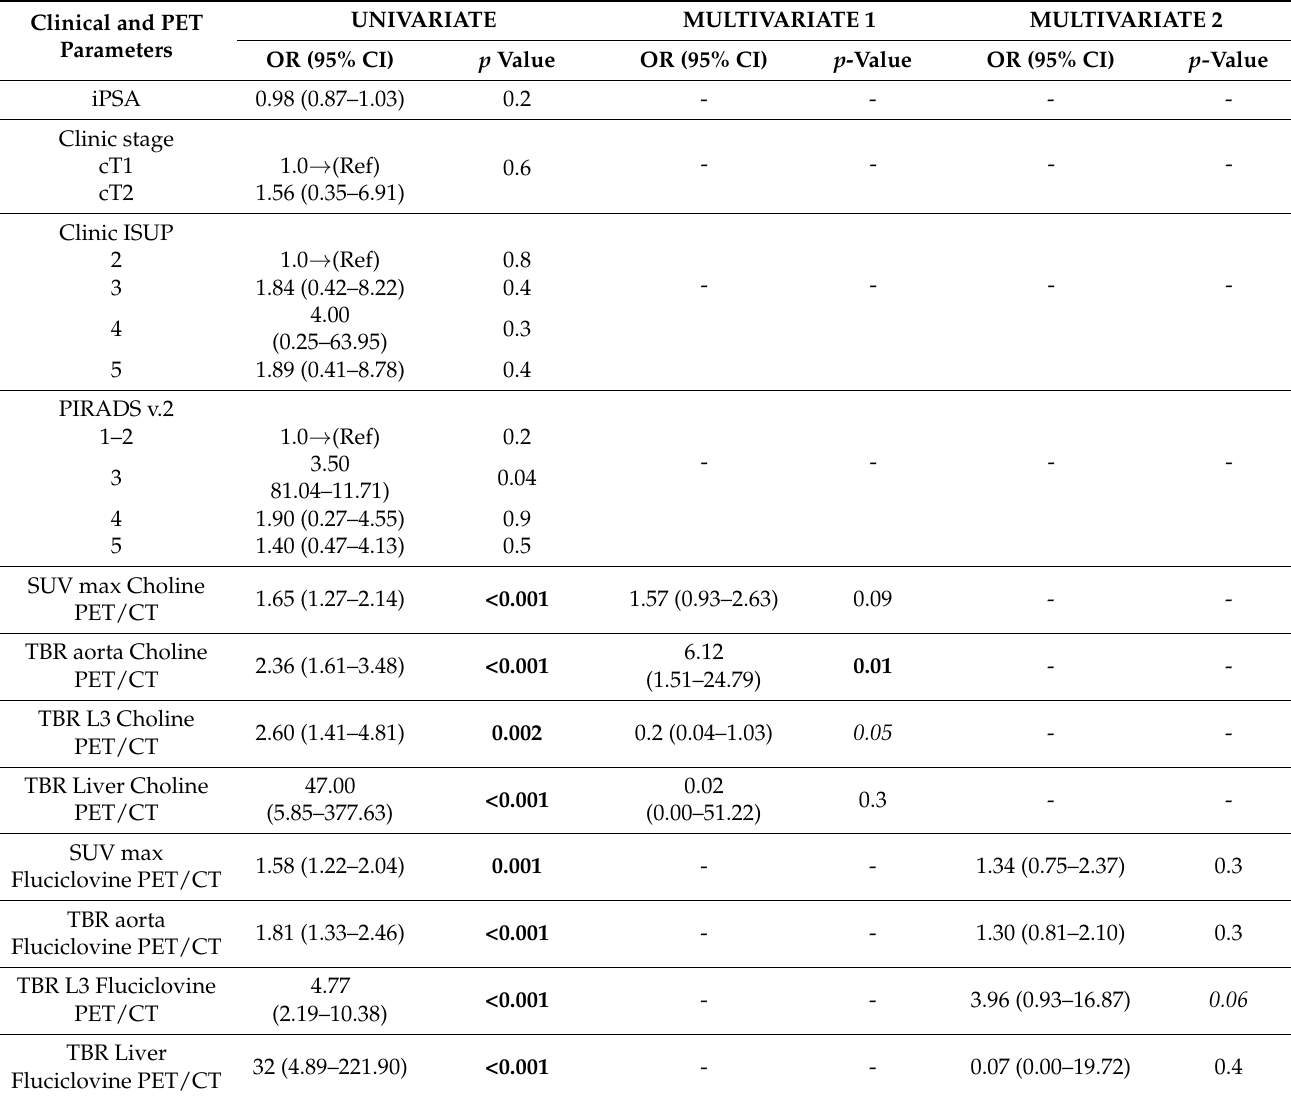
Table 7. Univariate and multivariate logistic regression to predict malignant lesion (lesion-based analysis, n = 45/95). Clinical and PET